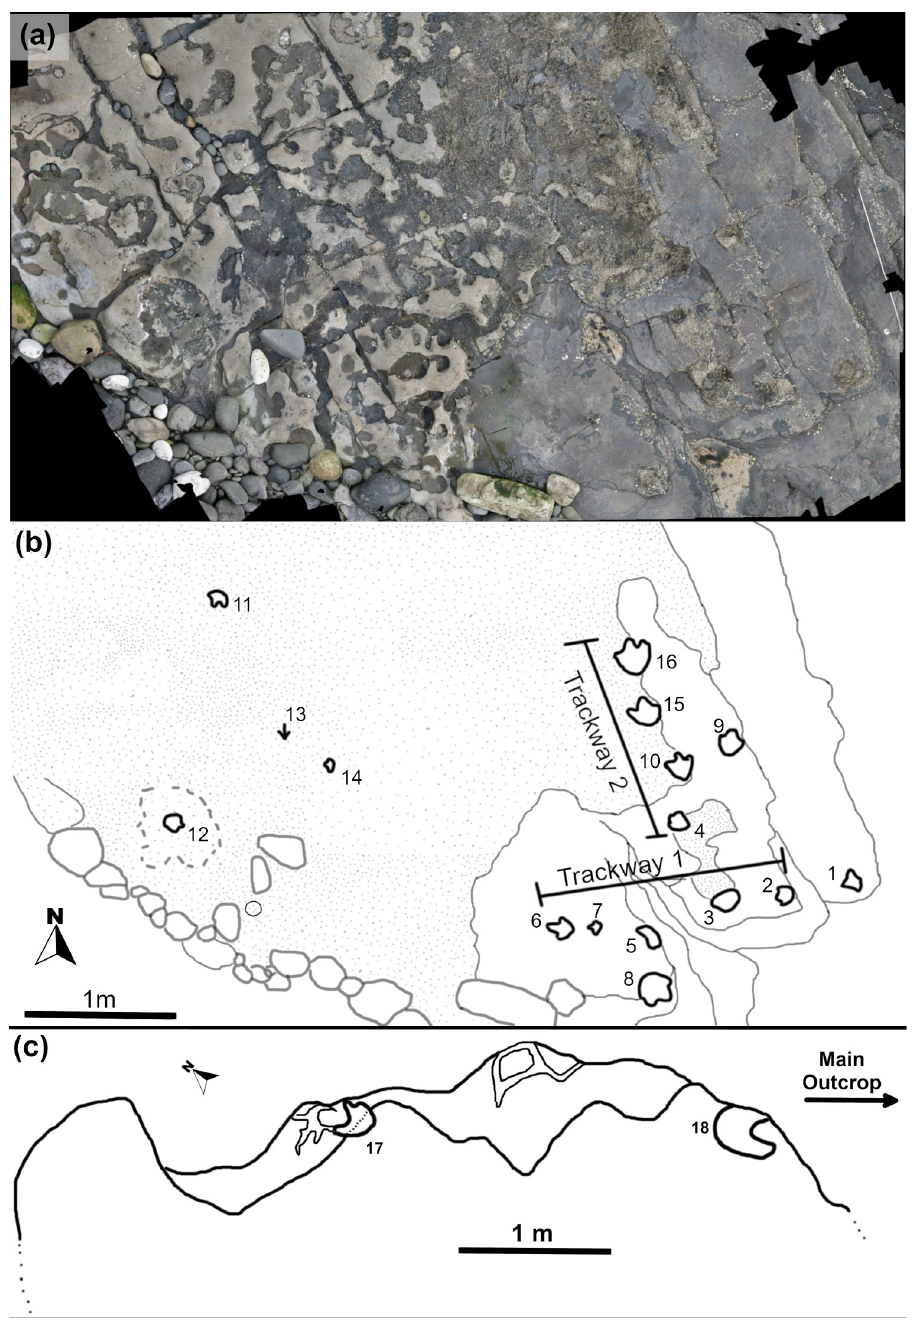
Fig 5. Orthophoto and site map of BP3. (a) The photogrammetric orthophoto of BP3 is oriented relative to geographic north. In this image, the largest concentration of tracks occurs in the southeast corner (lower left). Large tracks can be recognized a tan to gray disturbances in the otherwise smooth surface of the outcrop. (b) Line drawing of the site emphasizing both the locations of individual tracks (labeled with their field numbers; 1–16) and the path which trackways take (with Trackway 1–2 corresponding to BP3_Twy_01–02). The overlying limestone is denoted with light stippling. (c) The small extension of the main bedding plane of the track-bearing layer at BP3 is approximately 5 m to the north. Extensive mudcracks are present on the surface with some of the most prominent ones propagating from the toes of the two tridactyl tracks (17 and 18).